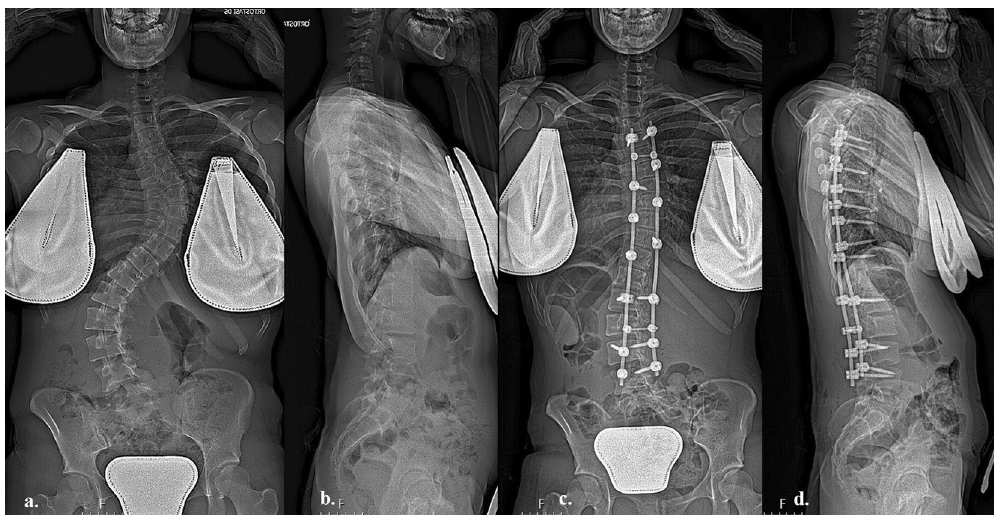
Figure 1. ( a ) Anteroposterior pre-operative long-cassette X-Ray of a 6 C-Adolescent Idiopathic Scoliosis in a seventeen years patients with Risser 5; ( b ) lateral pre-operative long-cassette X-ray showing hypokyphosis < 20°, ( c ) post-operative anteroposterior long-cassette X-ray showing satisfactory correction with all screw construct, ( d ) lateral post-operative long-cassette X-ray showing restoration of better